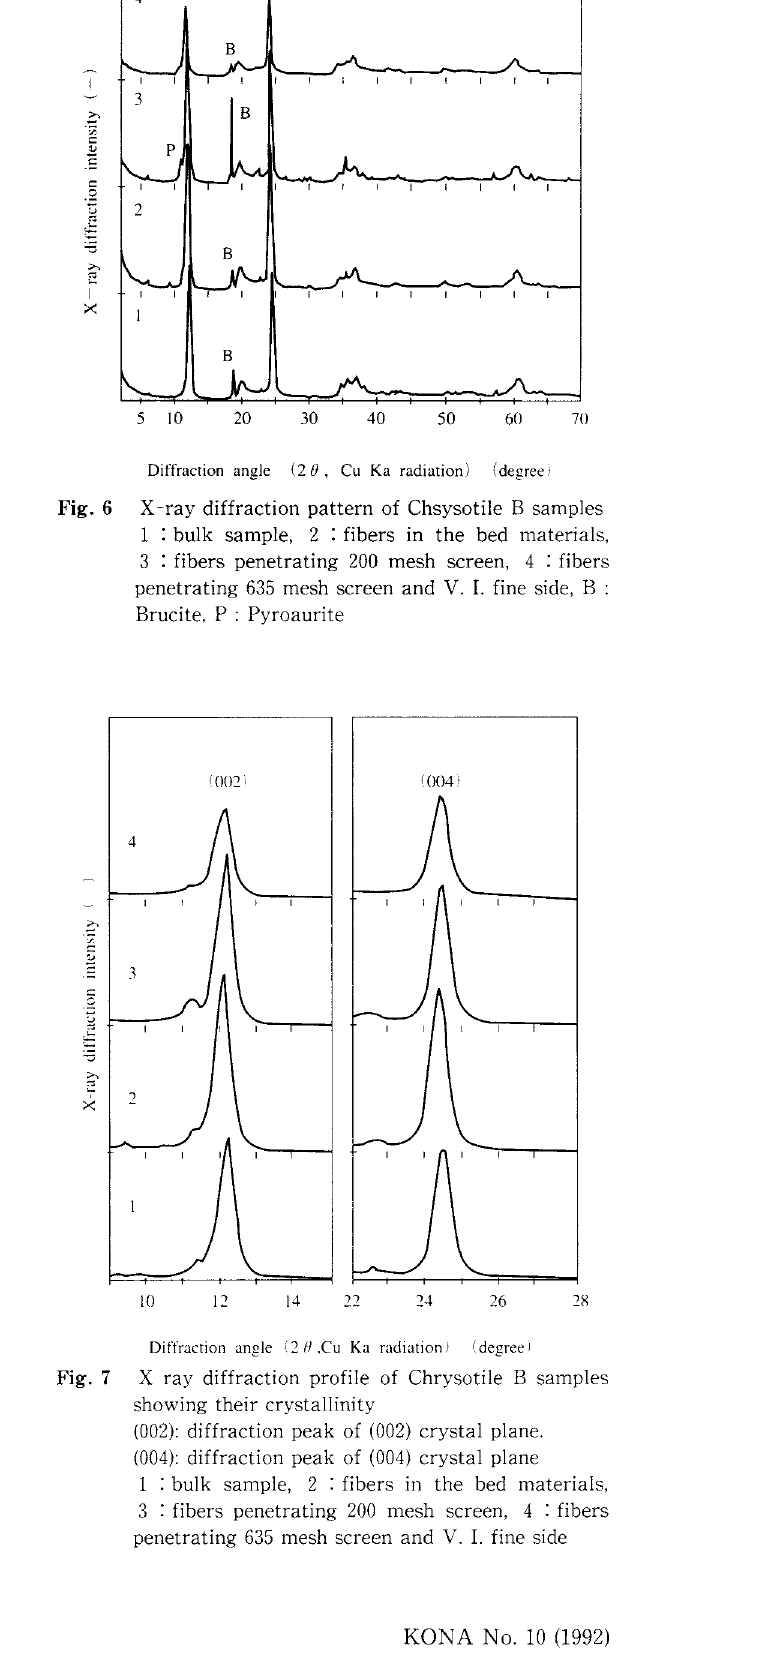
Fig. 7 X ray diffraction profile of Chrysotile B samples showing their crystallinity (002): diffraction peak of (002) crystal